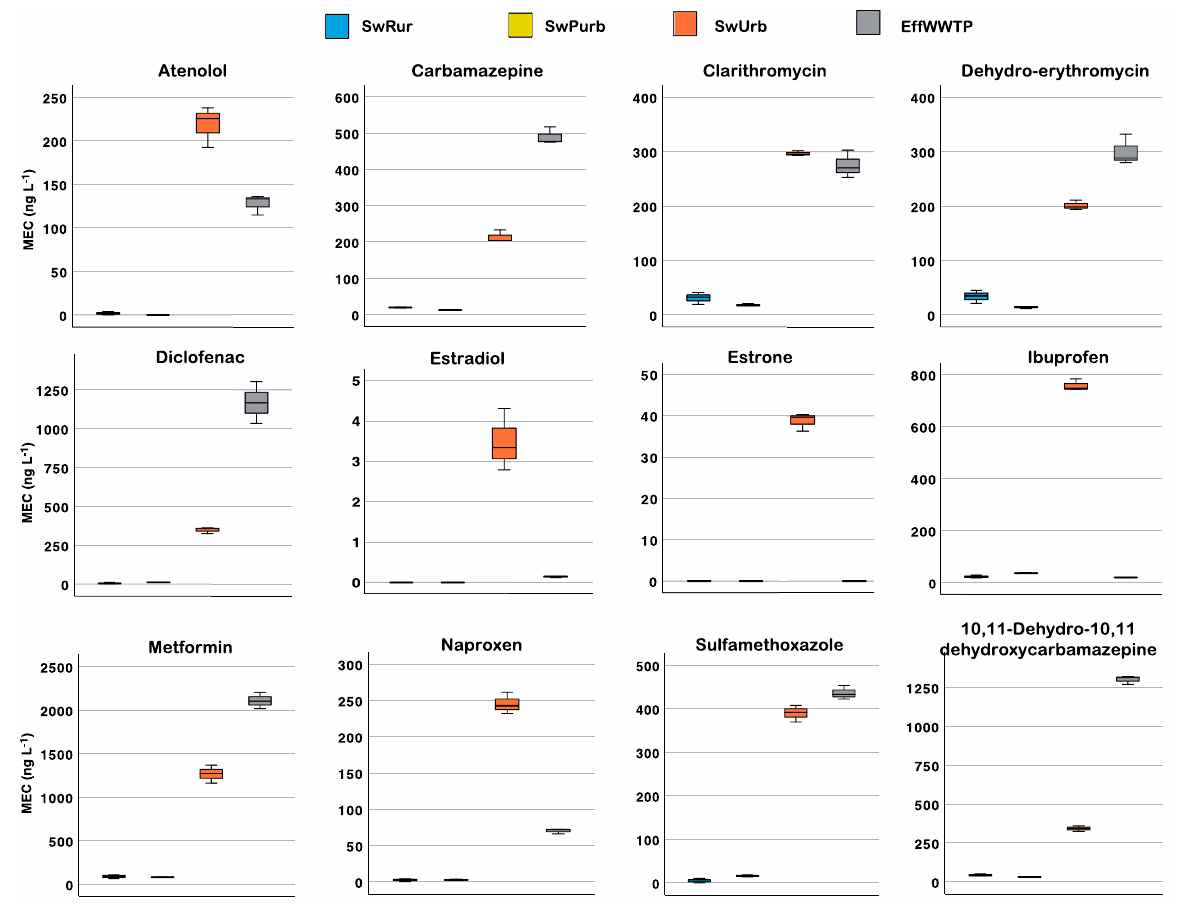
Figure 3. Box plot indicating measured environmental concentration (MEC) of selected pharmaceuticals (ng L − 1 ) in surface waters and effluent wastewater collected in September 2016 from the sampling points in a coastal area of Central Italy (SwRur: rural area; SwPurb: periurban area; SwUrb: urban area; EffWWTP: effluent of the wastewater treatment plant). The box indicates the 25th and 75th percentiles, the horizontal line indicates the median, and the whiskers indicate the lowest and the highest values. Dehydro-erythromycin and 10,11-dehydro-10,11-dehydroxycarbamazepine are metabolites of erythromycin and carbamazepine, respectively.